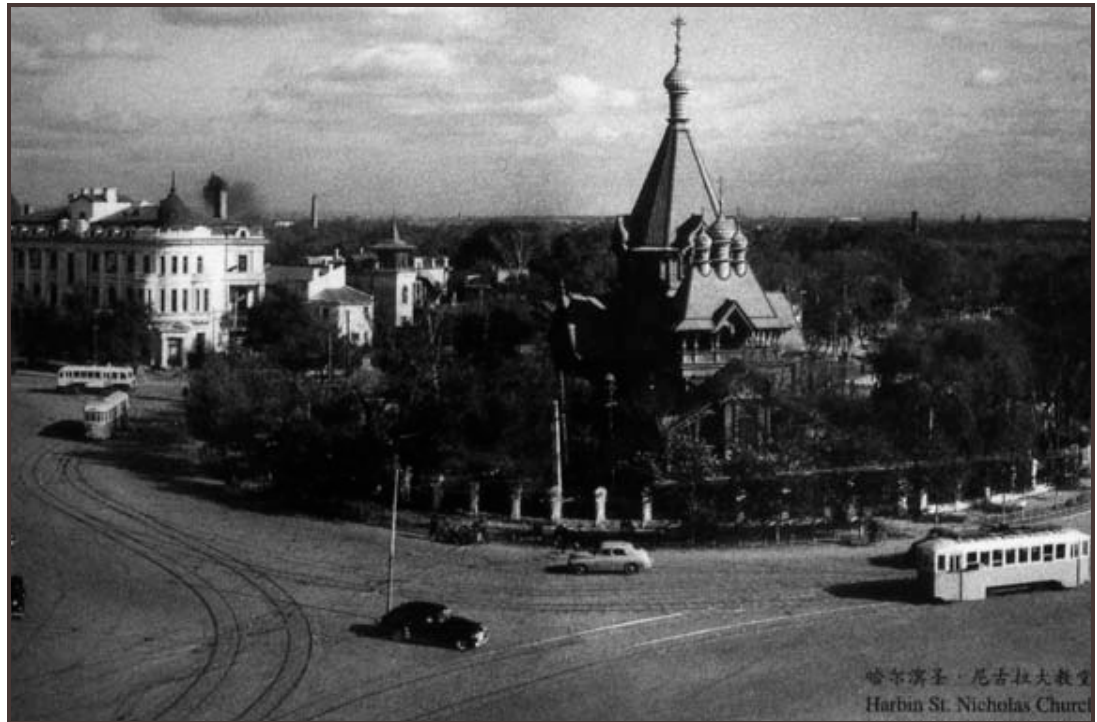
Fig. 1: St. Nicholas cathedral represented the Russian architecture that defined Harbin when Tanxu arrived in 1920. This photograph dates from the 1950s.